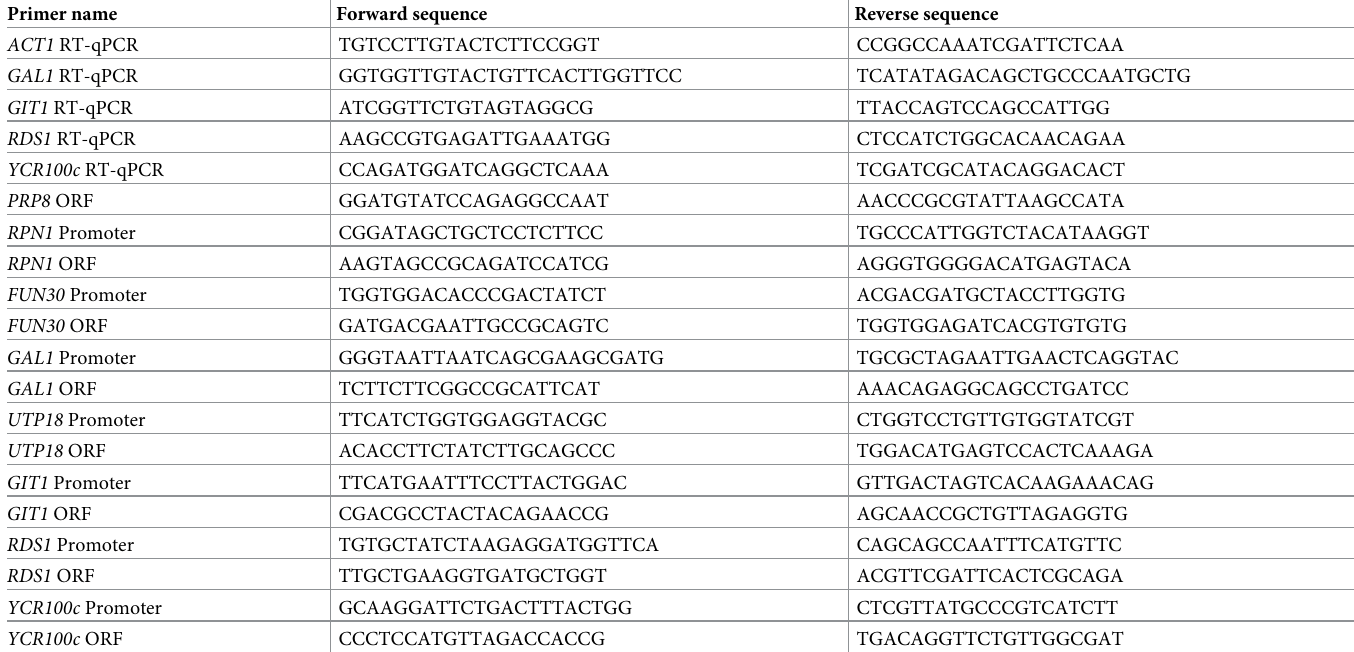
Table 3. RT-qPCR and ChIP-qPCR